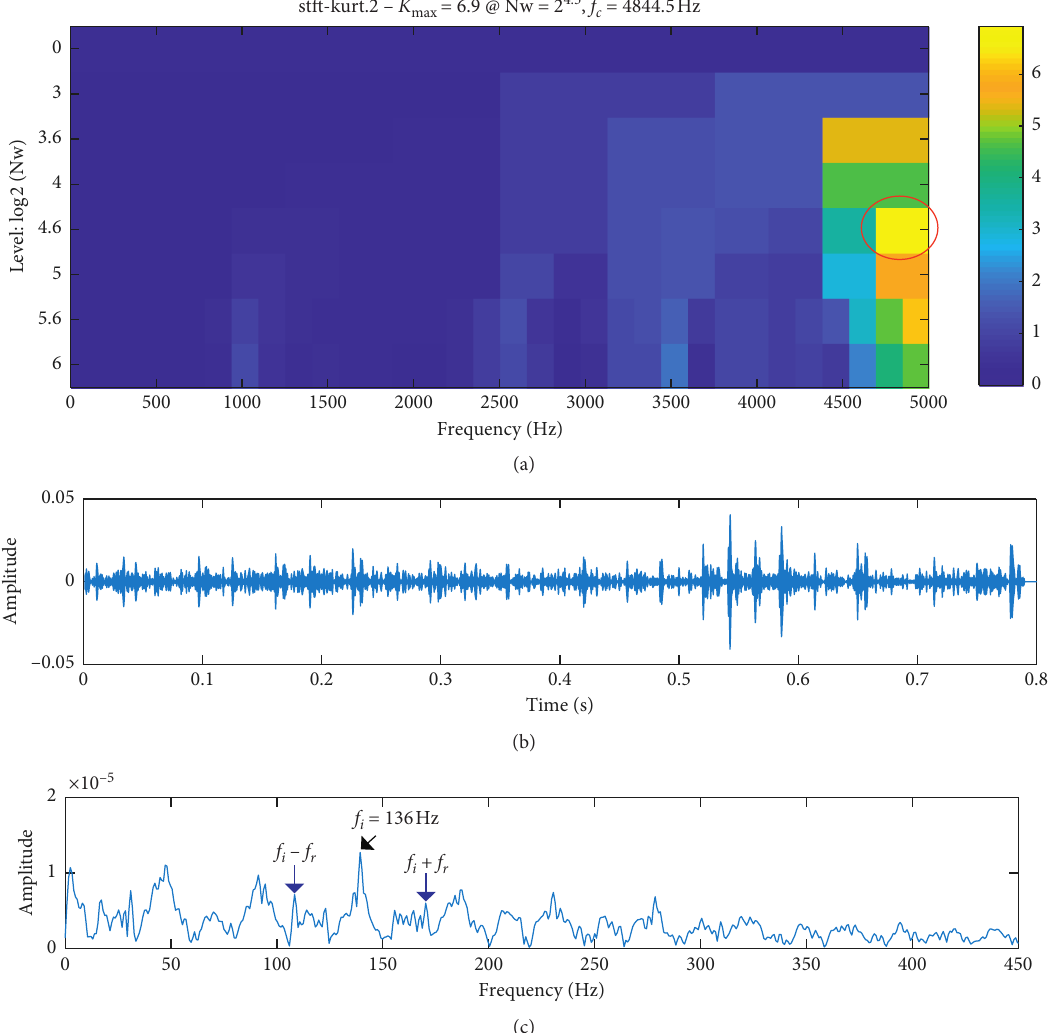
Figure 33: Multicomponents data in Figure 28(a) processed by the SK: (a) the paving of kurtosis values and (b) the signal filtered by frequency band (expressed by a solid read circle); (c) envelope spectrum of the filtered